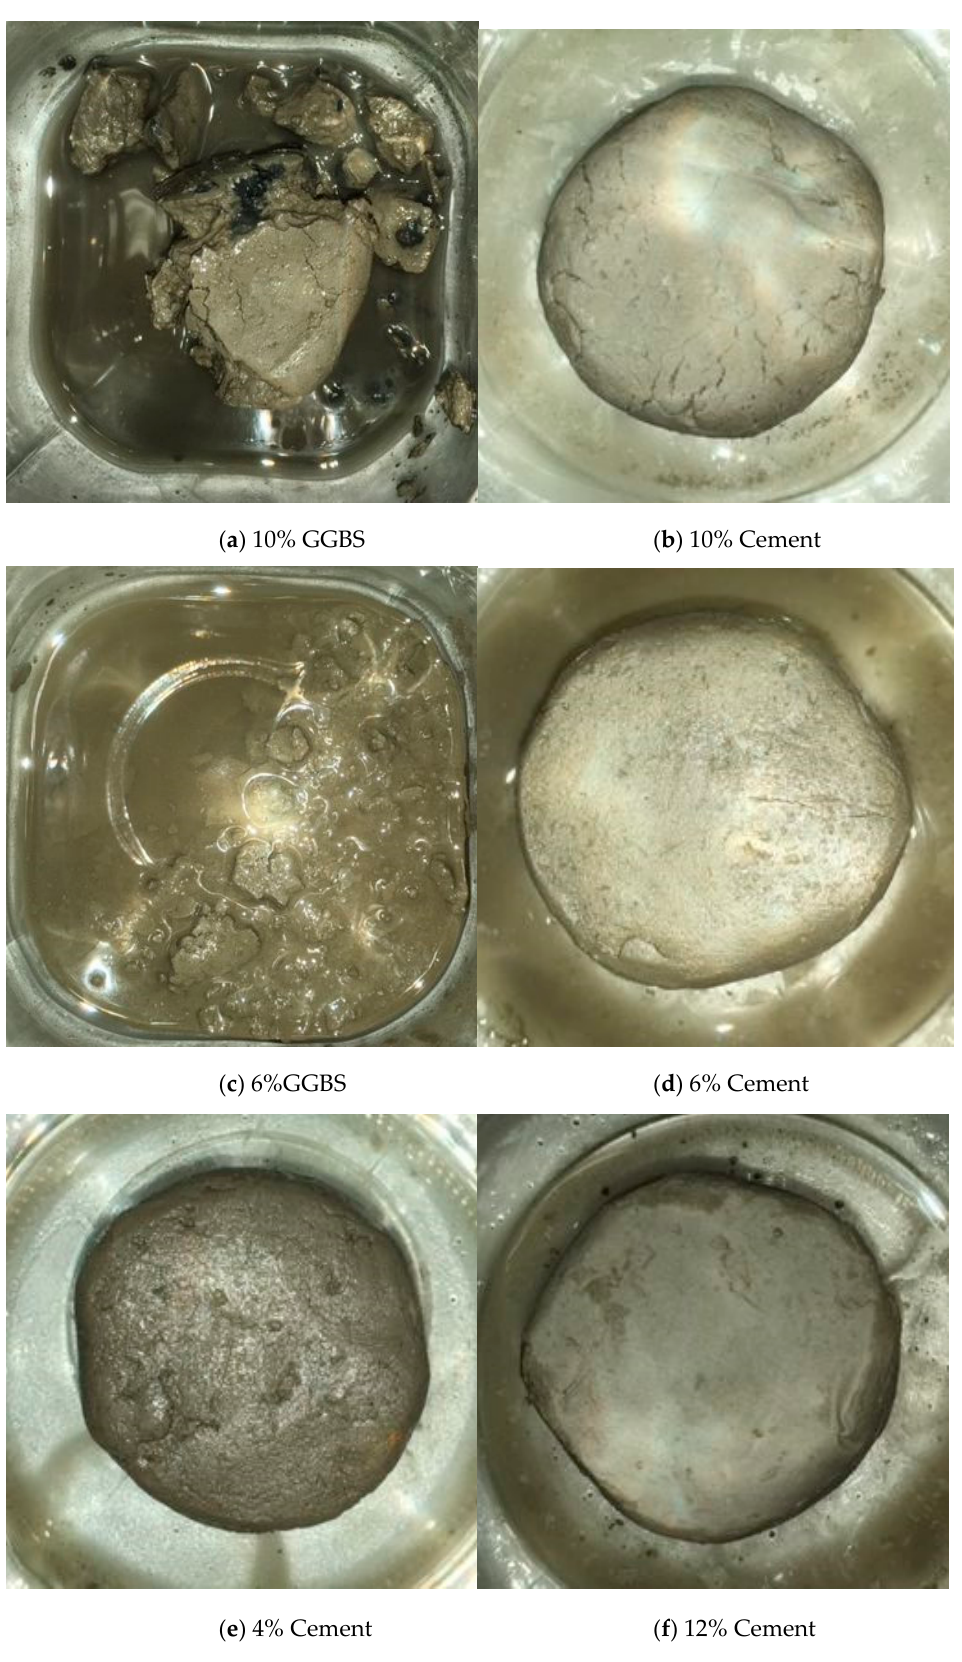
Figure 1. Monolith structure after tank testing.